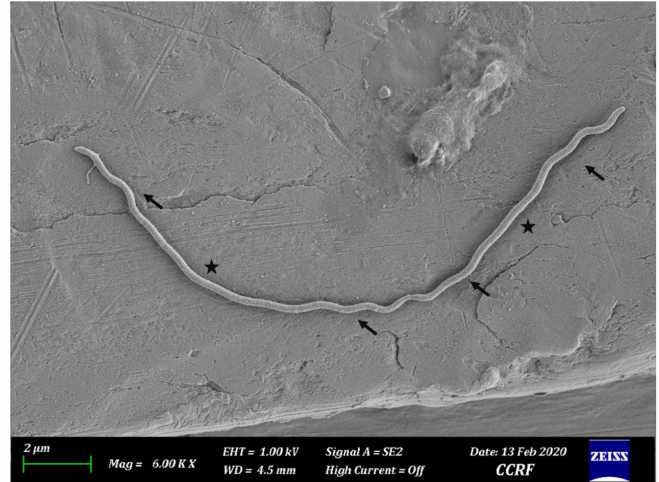
Figure 1. Treponema phagedenis cells under FE-SEM displaying moderate helical coils on both ends of the cells (arrow) with a semi-coiled region in the middle portion of the cells (star) at 6000 ×